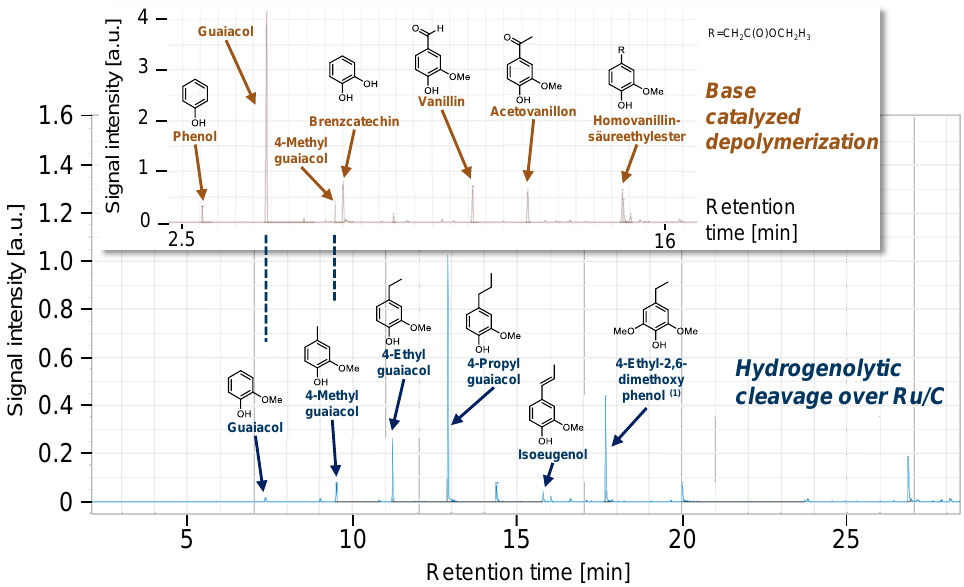
Figure 3. Typical gas chromatogram of lignin oil obtained by catalytic hydrogenolysis of kraft lignin in methanol (kraft lignin, Ru/C, 0.09 mmol Ru/g lignin, 30 bar H 2 at room temperature, 40 min) and assignment of the compounds (blue, (1) 4-ethyl-2,6-dimethoxyphenol or isomer) in comparison to the corresponding product mixture obtained by base-catalyzed depolymerization of kraft lignin (insert). Both chromatograms were measured on the same column and the scale was adjusted so that corresponding compounds match on the abscissa.